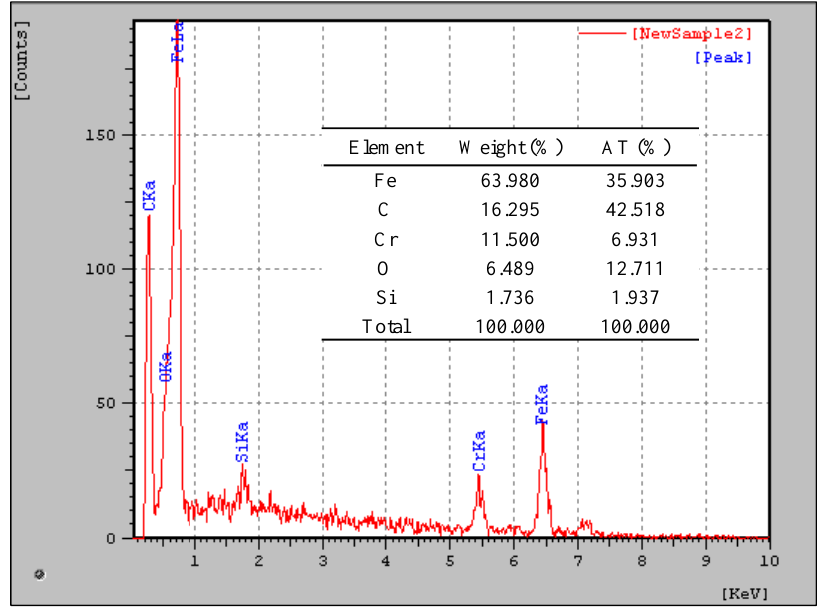
Figure 6. EDS analysis of the wear track surface.